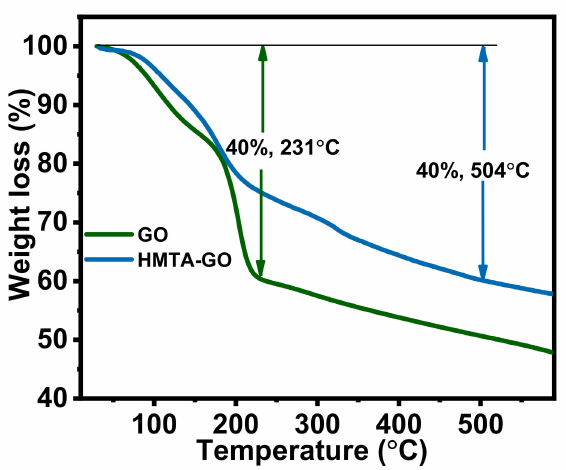
Figure 4. TGA curves for GO and